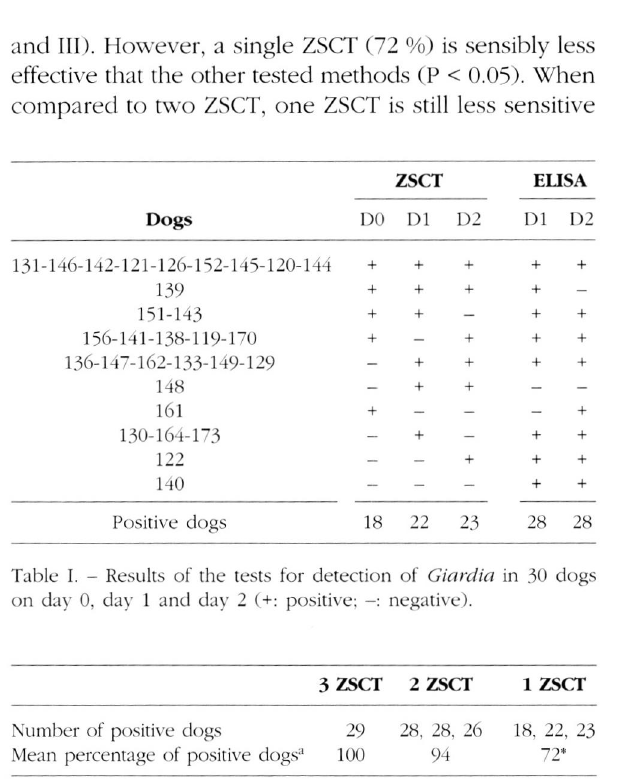
Table I. - Results of the tests for detection of Giardia in 30 dogs on day 0, day 1 and day 2 (+: positive: -: negative).